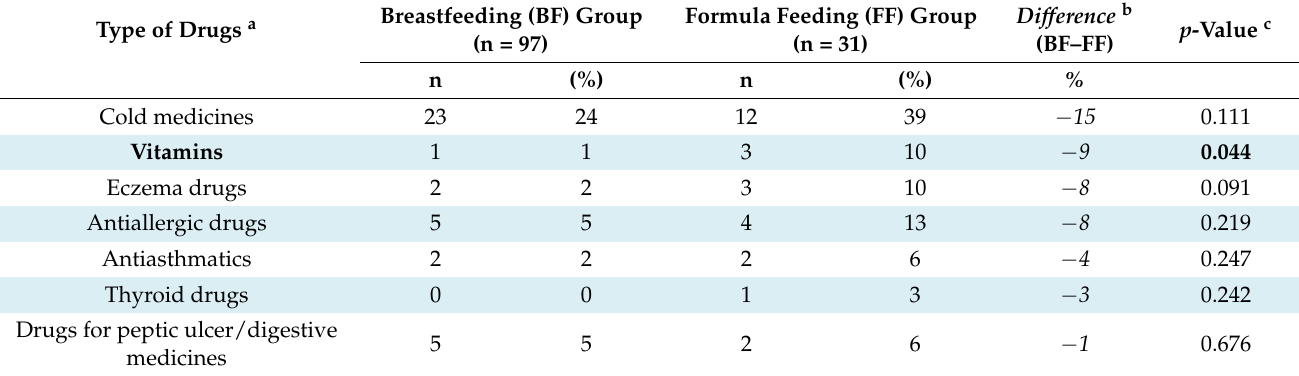
Table 3. Women’s use of prescription drugs in the postpartum